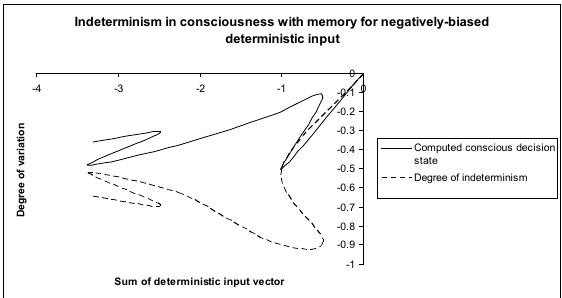
Fig. 19. Variation of state of consciousness in system with memory ( (cid:16) biased C1).